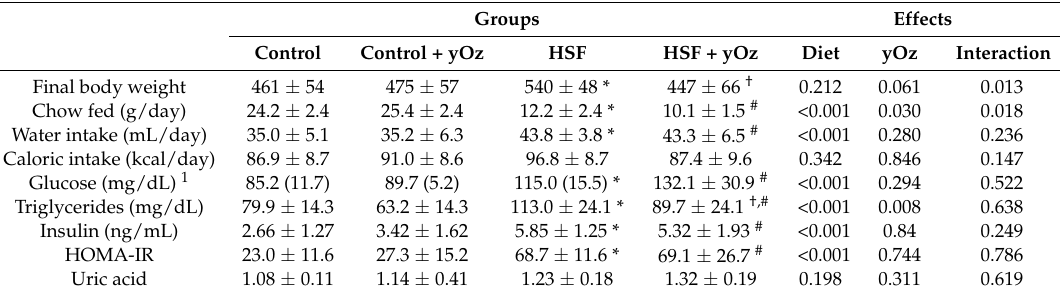
Table 2. Nutritional, metabolic, and hormonal analysis.